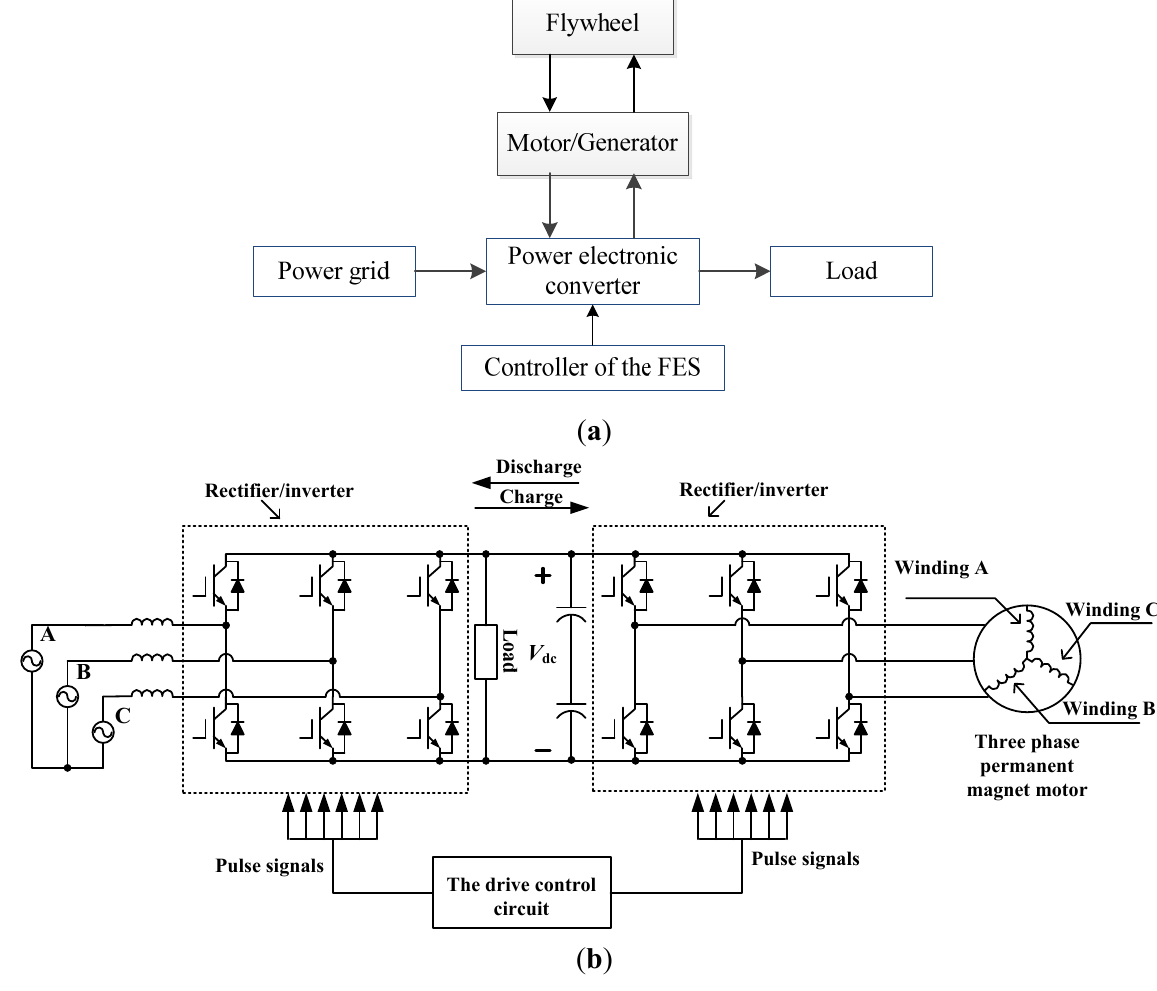
Figure 1. ( a ) System block diagram of the FES; ( b ) drive